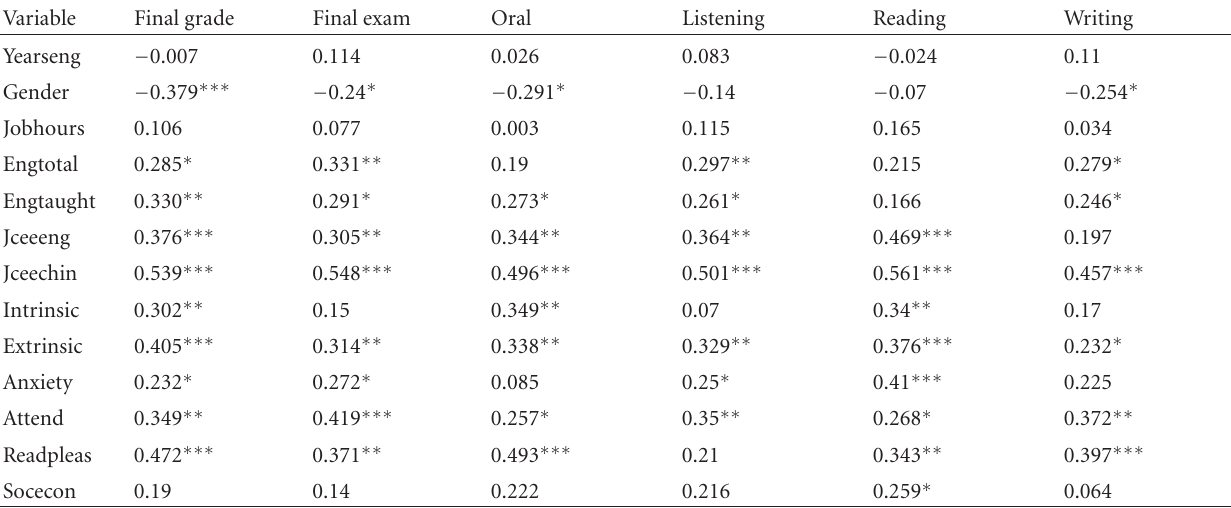
Table 3: Correlations between dependent and independent variables.